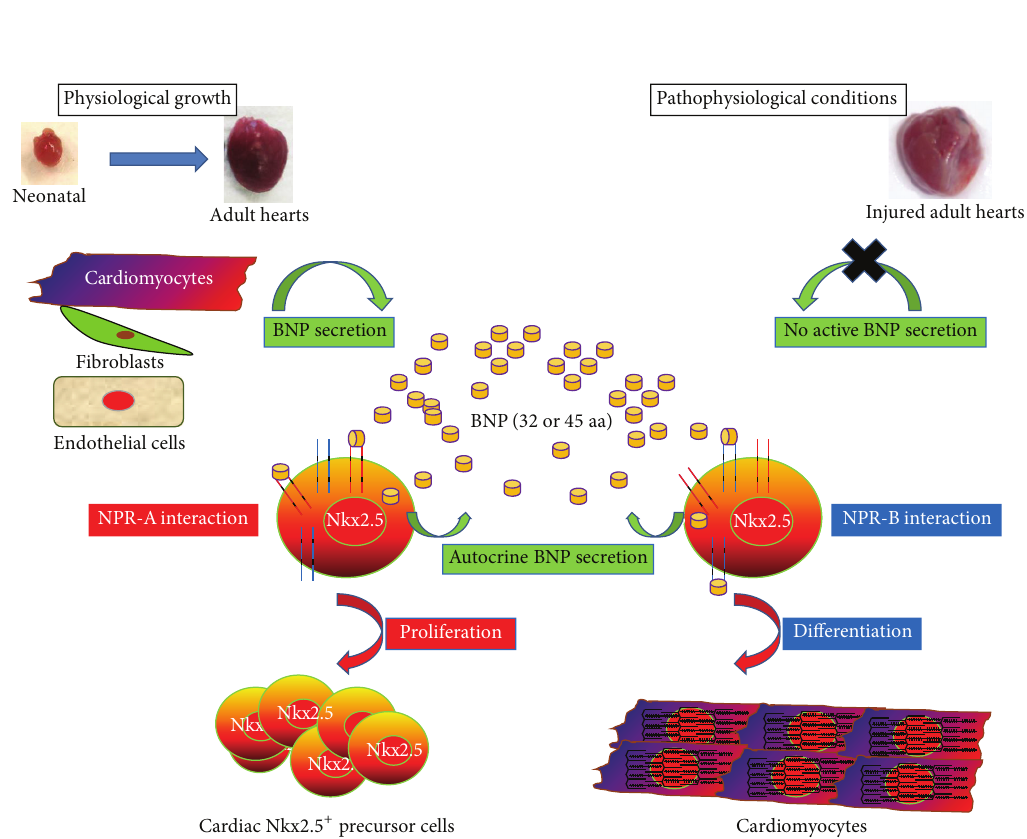
Figure 6: BNP modulation of cardiac precursor cell (CPC) proliferation and differentiation. BNP is secreted during physiological growth by cardiomyocytes, fibroblasts, and endothelial cells. CPCs can also secrete BNP. BNP stimulates via NPR-A CPC proliferation and via NPR-B CPC differentiation into cardiomyocytes. In pathophysiological conditions, it seems that the secreted BNP is devoid of biological activity, suggesting that BNP can be injected to stimulate the CPC proliferation and differentiation. This representation is based on the results previously published